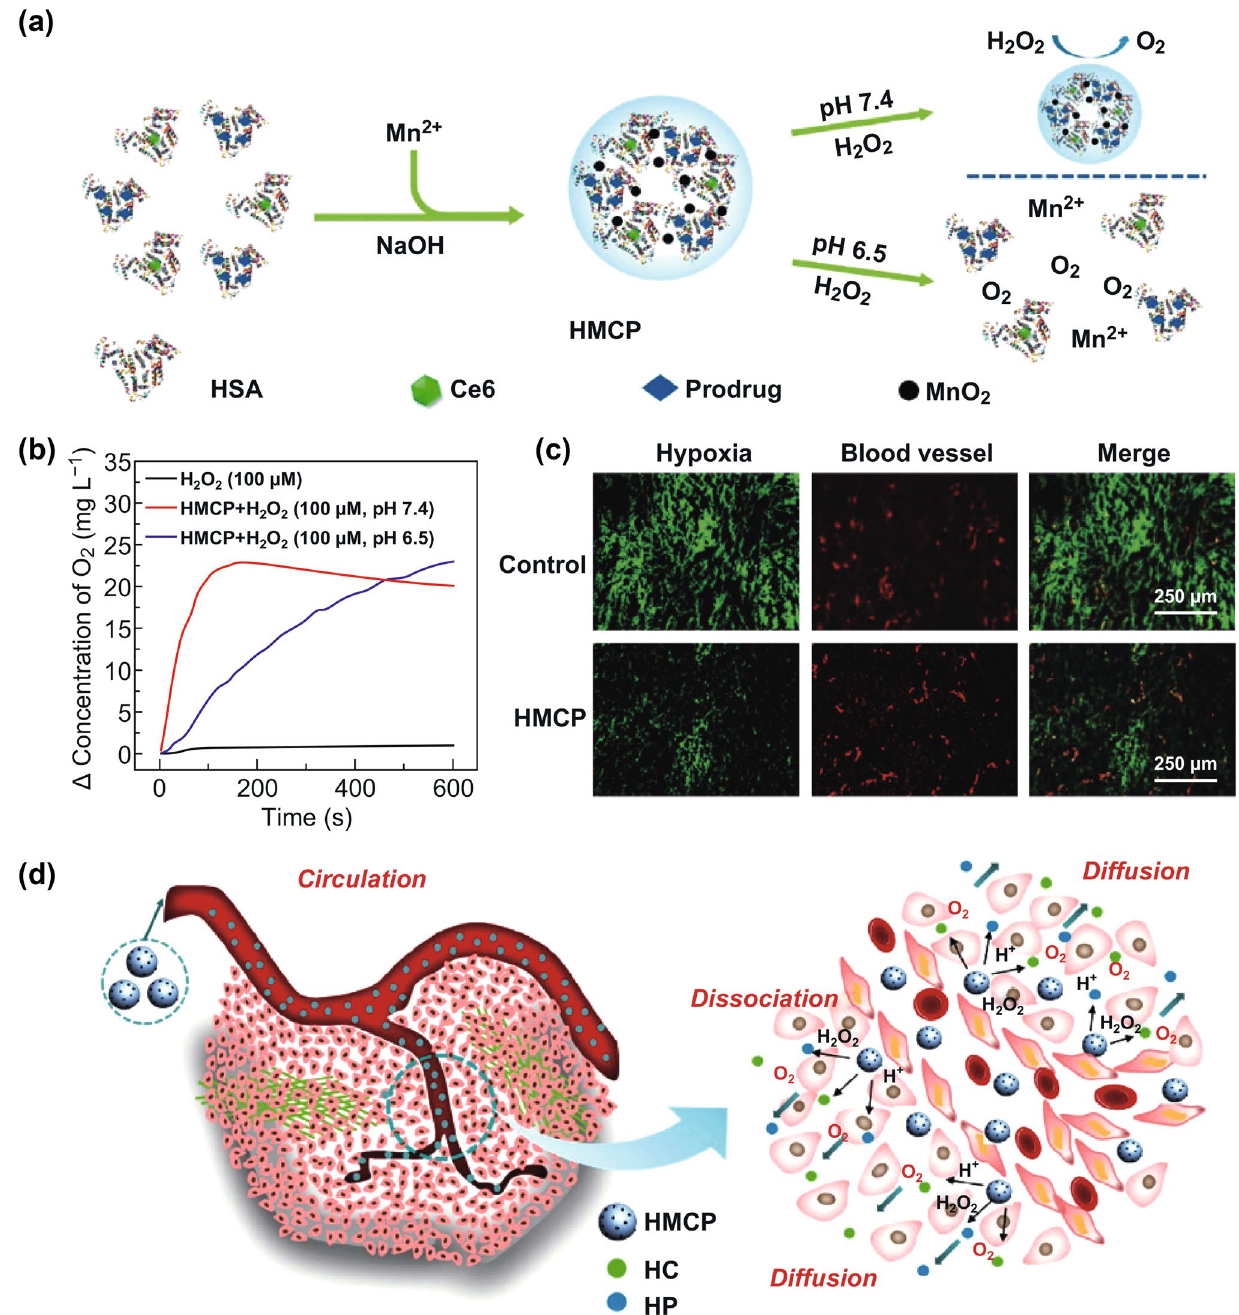
Fig. 1 a Schematic representation of the formation of HMCP nanoparticles. b HMCP was added at different pH values to generate oxygen in H 2 O 2 solution (100 × 10 −6 M). The decrease in oxygen concentration in the sample at pH 7.4 (after about 150 s) is due to the rapid consumption of H 2 O 2 . c Representative immunofluorescence images of tumor sections after hypoxia staining. Hypoxic areas and blood vessels were stained with anti-pipemole antibody (green) and anti-CD31 antibody (red). d Scheme of the disintegration of HMCP nanoparticles by in situ chemical reaction in the TME for synergistic PDT and chemotherapy. Adapted with permission from Ref. [14]. Copyright 2016